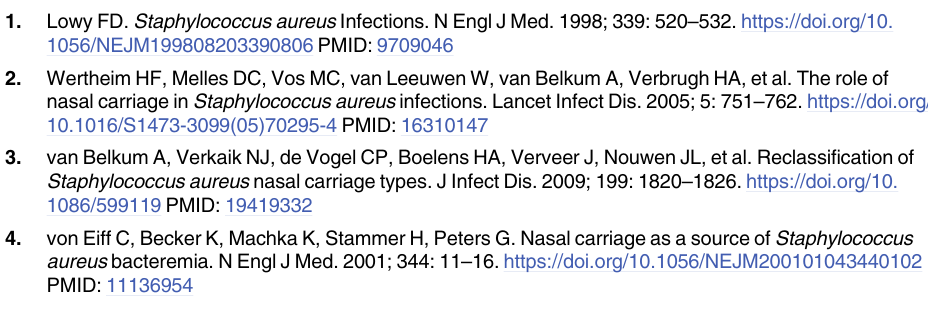
-transformed CFU 10